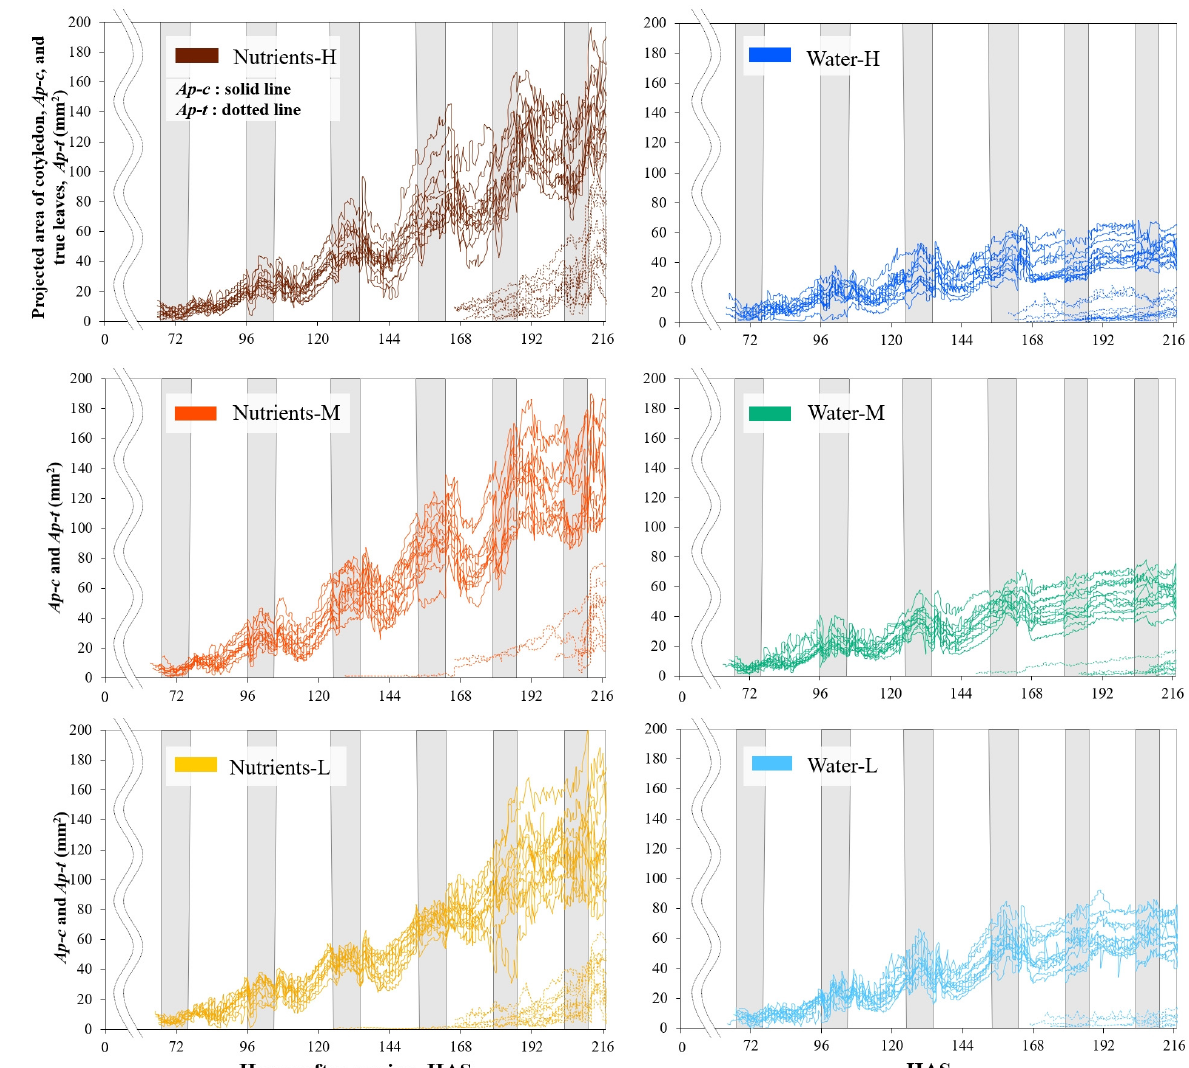
Figure 4. Time-course projected areas of the cotyledon ( Ap-c ) and true leaves ( Ap-t ) of individual seedlings with nutrients and water from hours to cotyledon unfolding from sowing ( Hc ) to 216 h after sowing (HAS), each with distributions of horizontal PPFDs (see Table 1 for treatments and codes). By estimating the projected areas of cotyledons and true leaves of individual seedlings separately, we demonstrated time-course changes of Ap-c and Ap-t , respectively (Figure